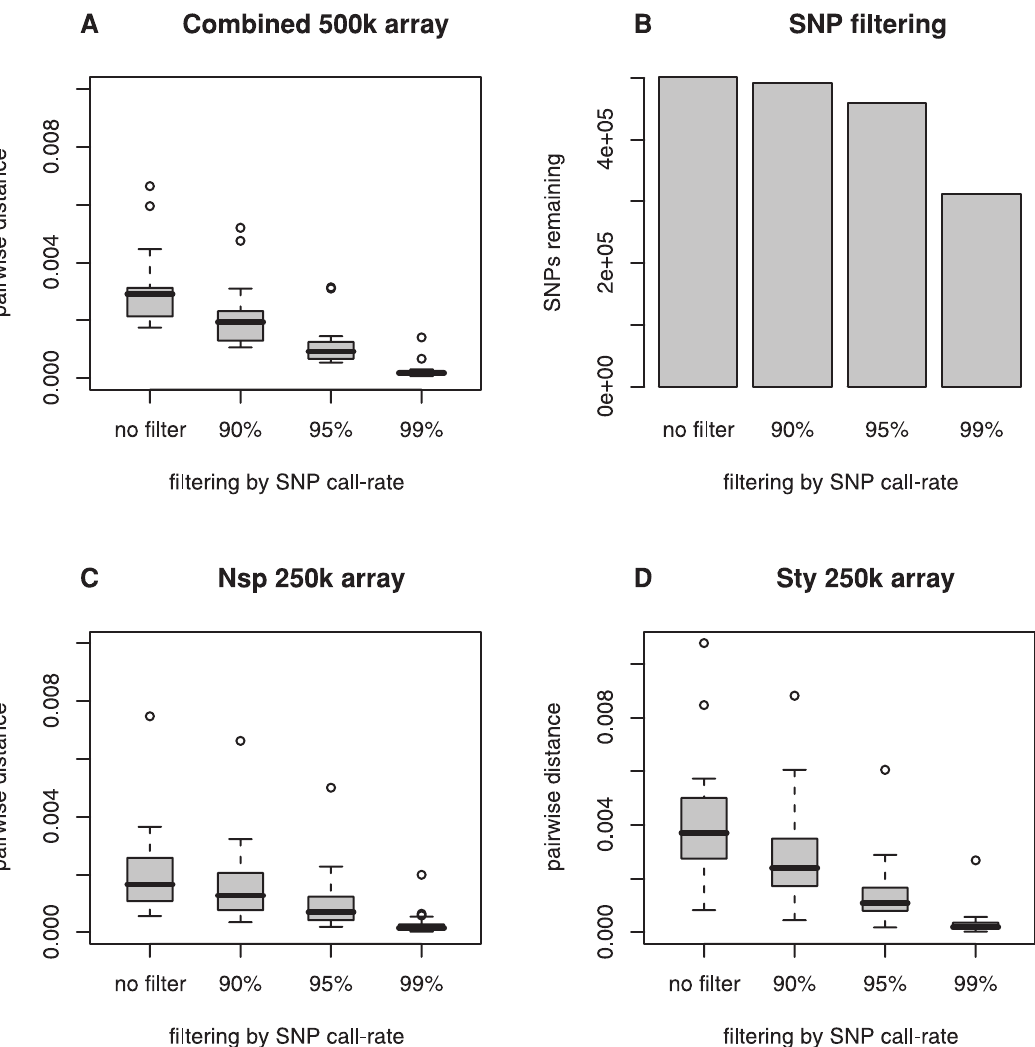
Figure 1. Genotypic fidelity of LCL. Genotypic fidelity is shown as mean pairwise distances among 19 paired comparisons of LCL and PBMC genotypes, for increasingly stringent SNP filtering by population call rate. A) Genotypic fidelity between LCL and PBMC source DNA from the same individual, estimated using the Affymetrix GeneChip Human Mapping 500 k Array set. B) SNP numbers remaining after filtering, shown for the combined 500 k array. C) Genotypic fidelity between LCL and PBMC source DNA from the same individual shown for the Nsp 250 k array. D) Genotypic fidelity between LCL and PBMC for the Sty 250 k array.